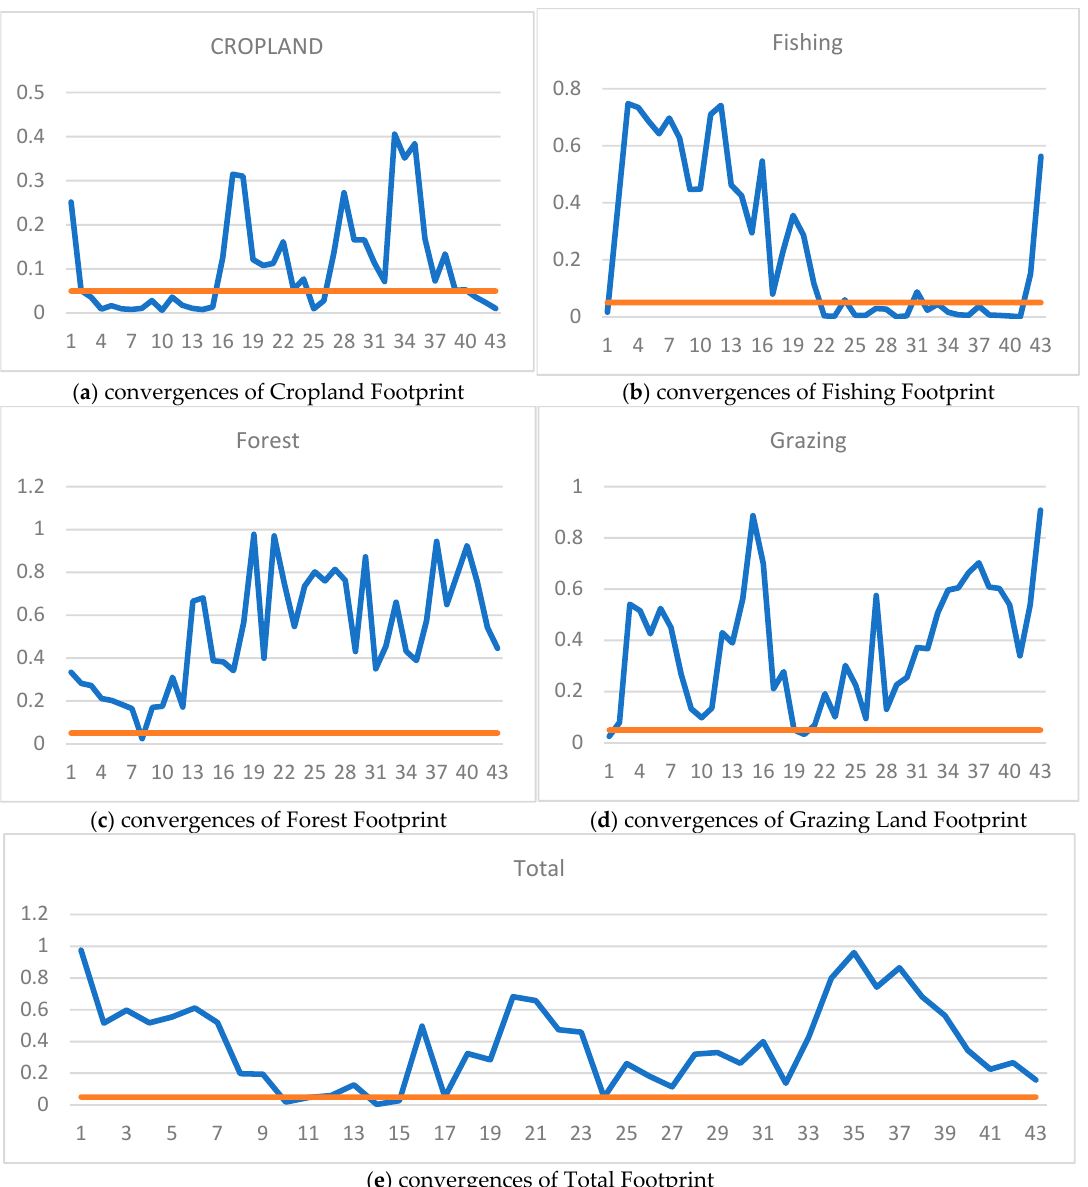
Figure 1. Intercept Model Results.